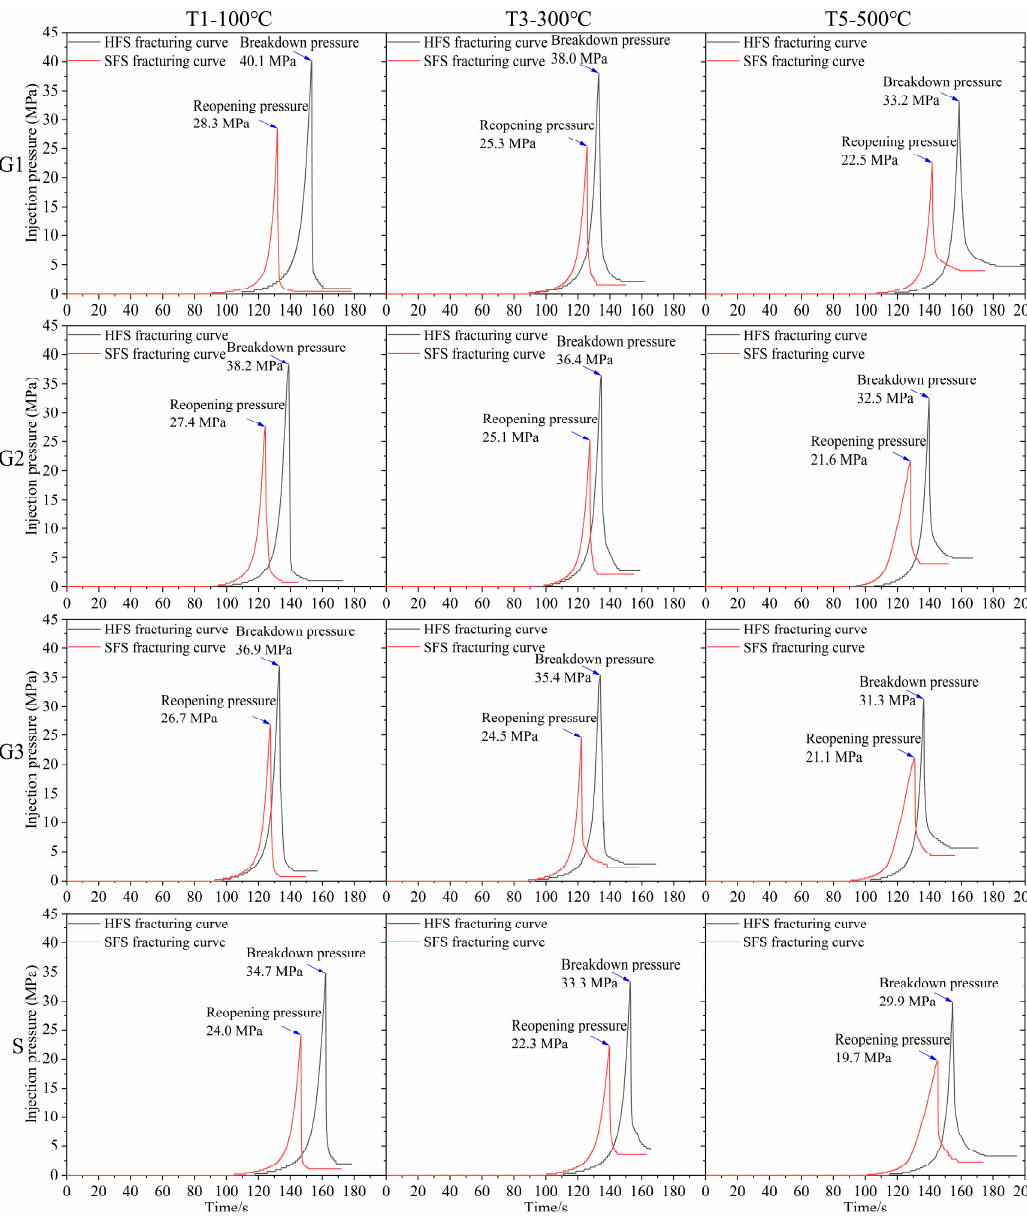
Figure 11. Fracturing curves for HFS and SFS specimens of four lithologies at different temperatures. Table 1. Breakdown pressure, fracture toughness and tensile strength of specimens at various tem- peratures and lithologies.